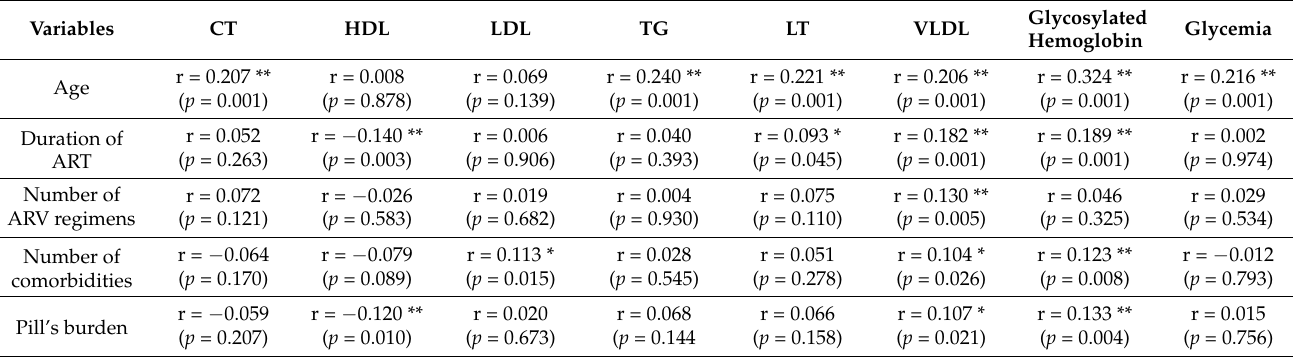
Table 4. Pearson correlation on the risk of impaired carbohydrate and lipid metabolism in HIV + patients (N =